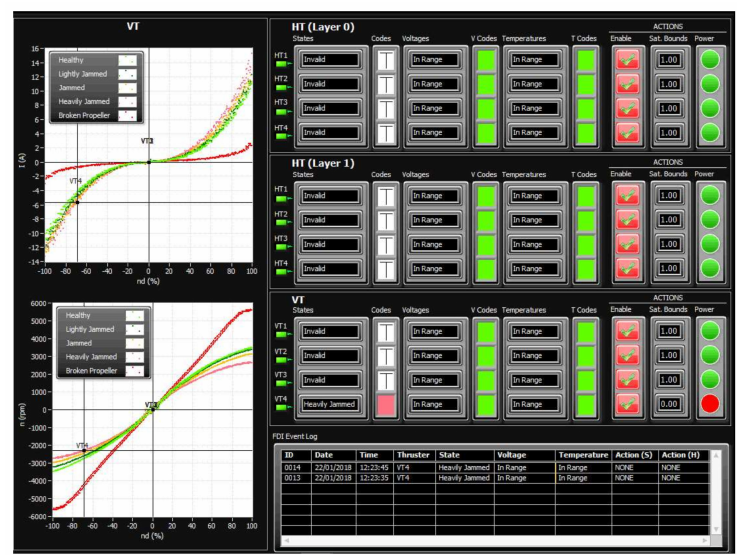
Figure 19. Thruster FDI result for thruster state = “Heavily Jammed”.